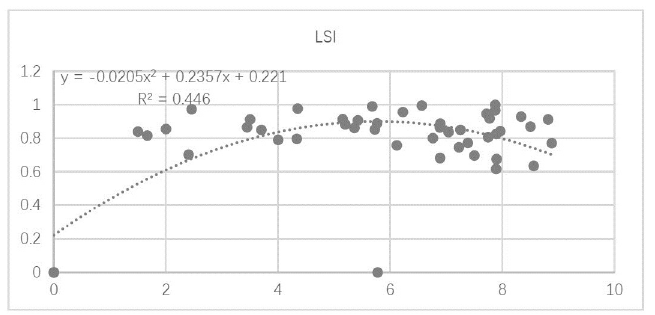
Fig 9. Relationship between landscape shape index (LSI) and forest ecosystem service